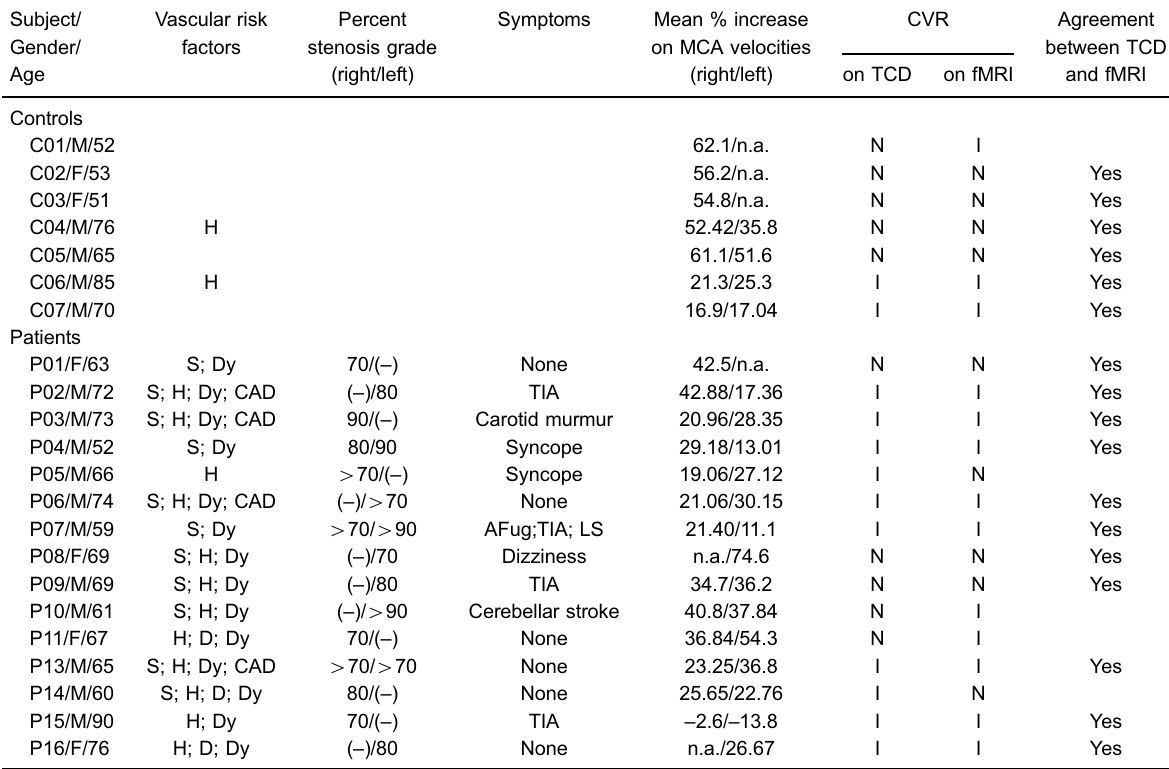
Table 2. Demographic data and vascular parameters in carotid stenosis patients and age-matched